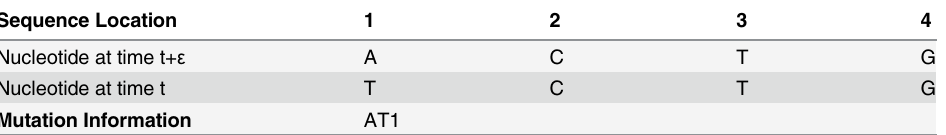
Table 1. Demonstration of Annotation Format.